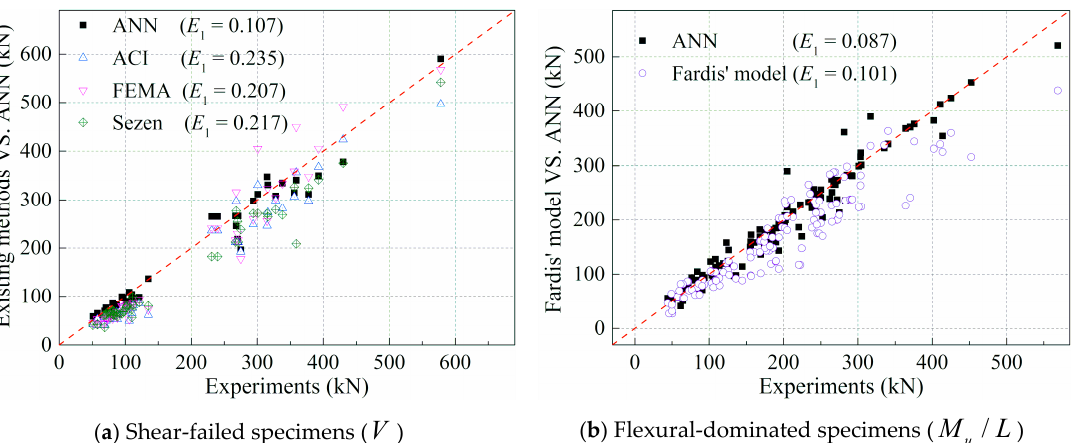
Figure 7. Comparison of the predicted results of the strength from the ANN model and existing explicit formulas.